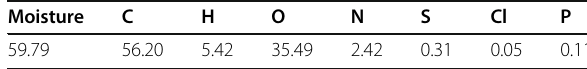
Table 3 Moisture and major elemental composition (%) of